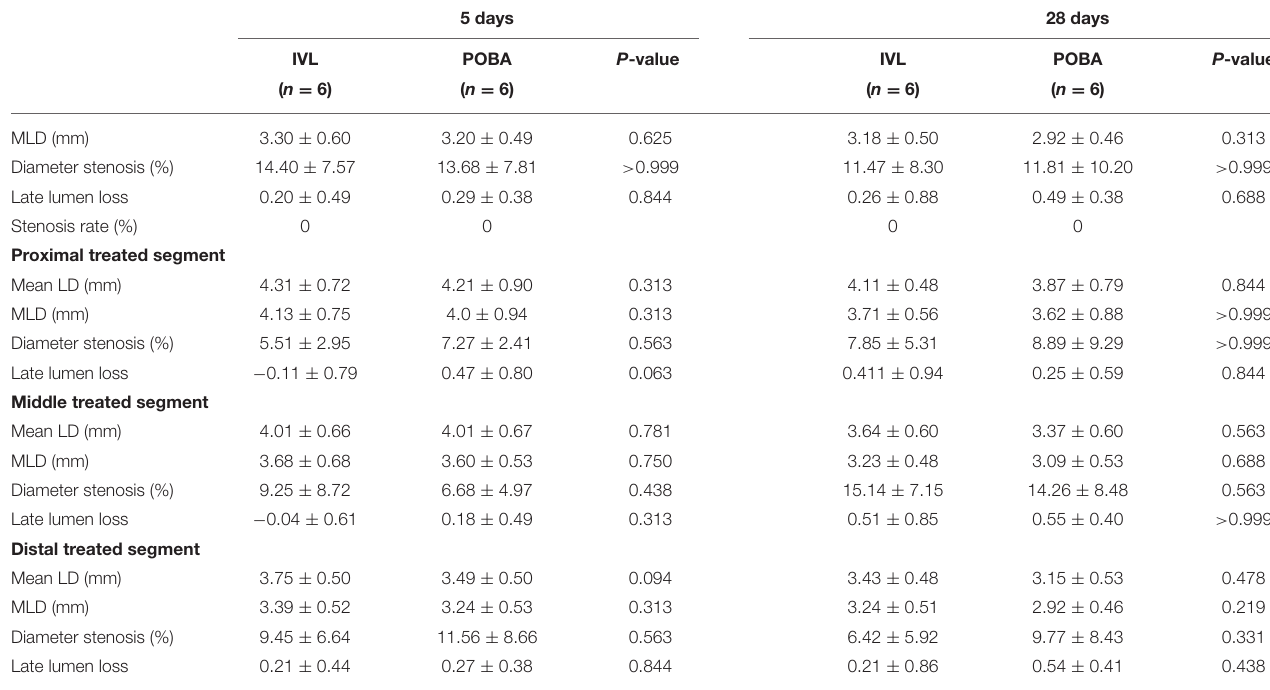
TABLE 1 | Comparison of quantitative vascular angiography results between intravascular lithotripsy and plain old balloon